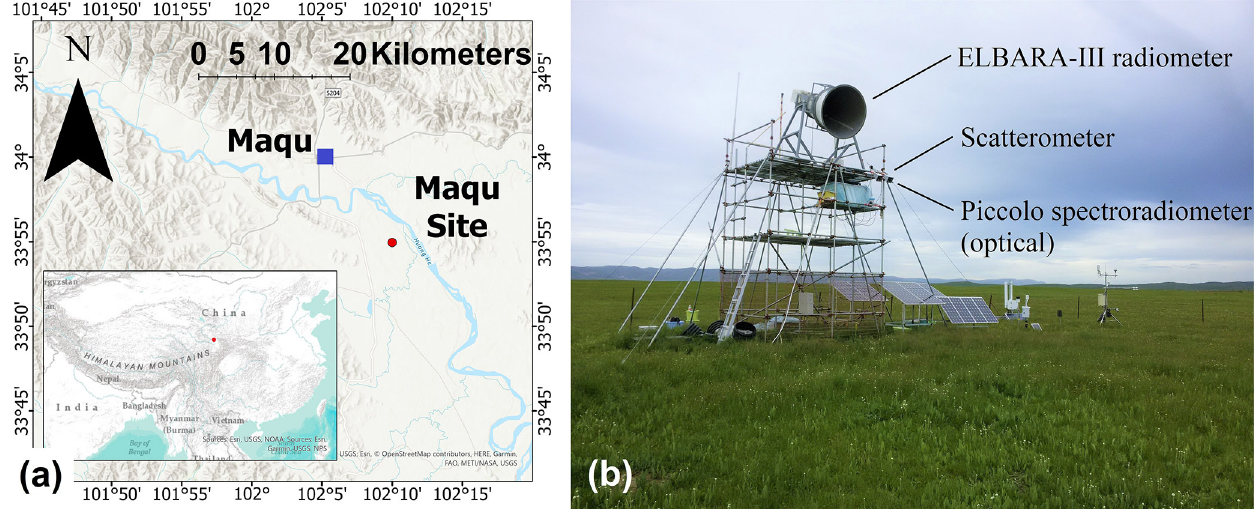
Figure 1. (a) Location of Maqu measurement site on eastern part of the Tibetan Plateau. (b) Tower of Maqu site containing the scatterometer, the ELBARA-III radiometer, and Piccolo optical spectroradiometer.